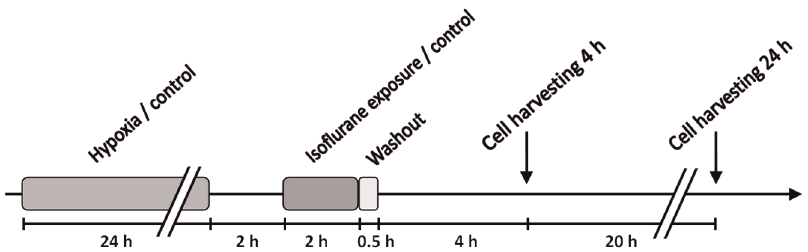
Figure 1. Study Protocol. Diagram of the study setup displaying the time course of experimental interventions performed on transdifferentiated proteins were blotted for 60 min at 300 mA on Membrane Hybond-CExtra nitrocellulose (Amersham, Bucks, UK). Thereaf-